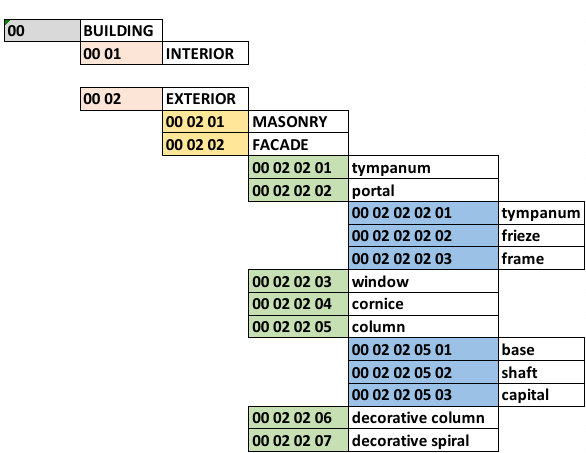
Figure 11. Tree-structure database with the ID-code assigned to each component